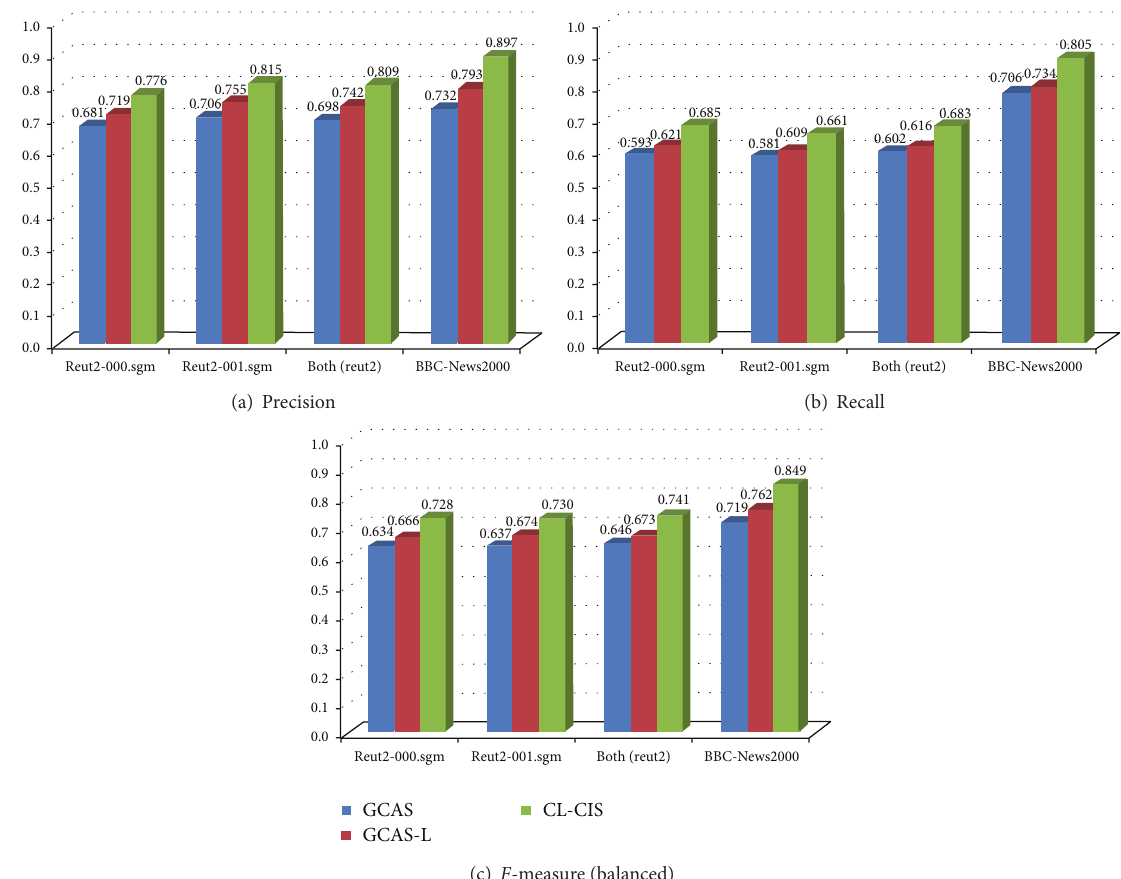
Figure 5: Evaluation results of GCAS, GCAS-L, and CL-CIS.